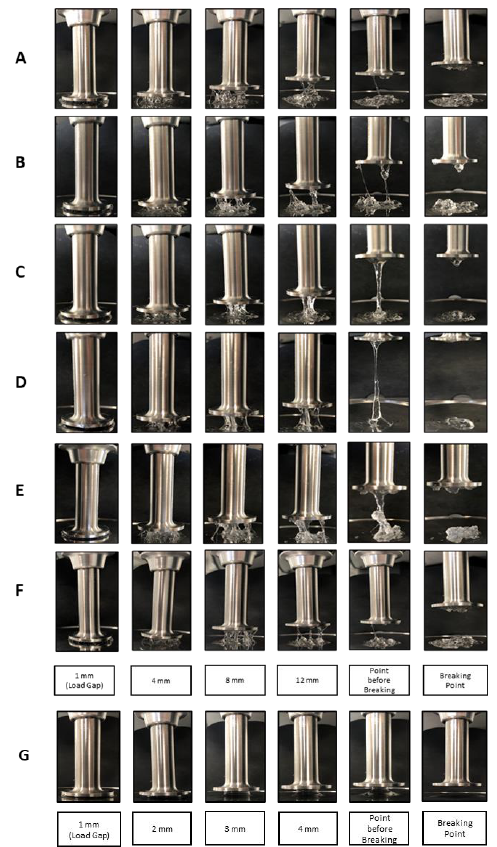
Figure 7. Vertical elongation comparison between seven dermal fillers illustrating the tendency of a cohesive product to stick to itself. ( A ) HA hydrogel 22 mg/mL; ( B ) HA hydrogel 24 mg/mL; ( C ) HA hydrogel 26 mg/mL LV; ( D ) HA hydrogel 26 mg/mL LR; ( E ) HA hydrogel 26 mg/mL with CaHA; ( F ) HA hydrogel 28 mg/mL; ( G ) HA non cross-linked hydrogel 18 mg/mL. For each sample, the load gap (1 mm) and the standard intermediate gaps of 4-8-12 mm and 2-3-4 mm, respectively, for the cross-linked ( A – F ) and non-cross linked ( G ) fillers, were evaluated together at the point before breaking and at the breaking